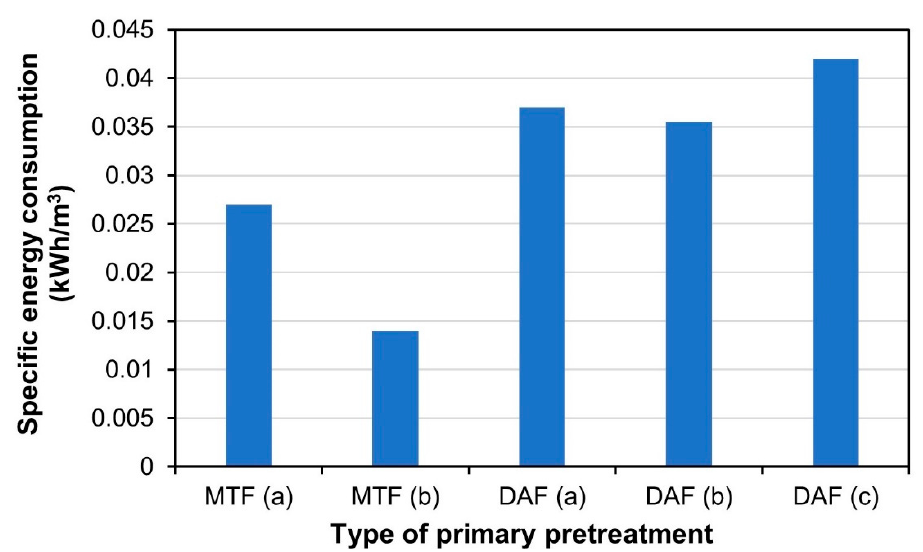
Figure 10. Comparison of specific energy consumption (SEC) of DAF and MTF. The SEC data of MTF ( b ); DAF ( a ); DAF ( b ), and DAF ( c ) were from Cha et al. 2020 [10].